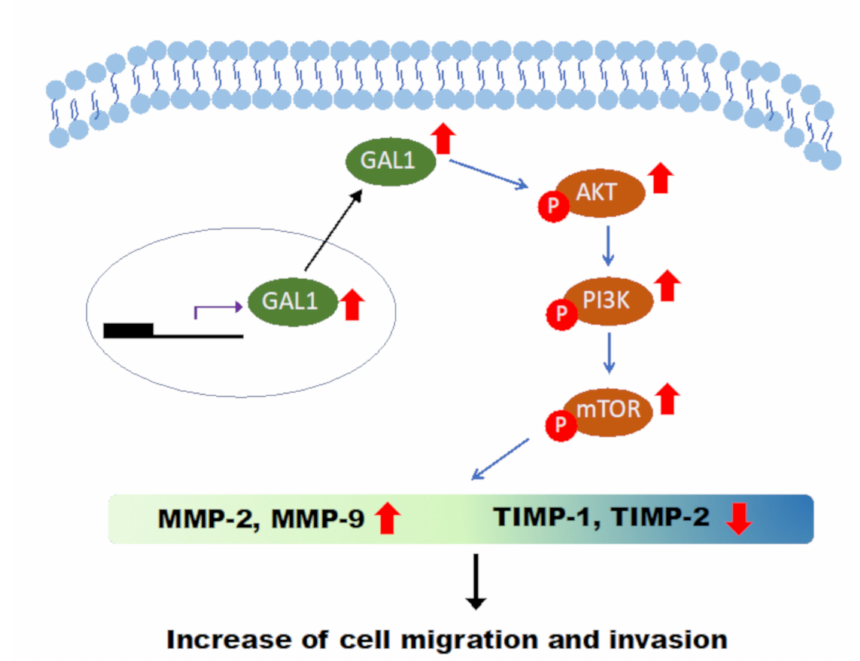
Figure7. RepresentativeFigureofGAL1-inducedcancerousbehaviorinUTUCcells: Basedontheresults